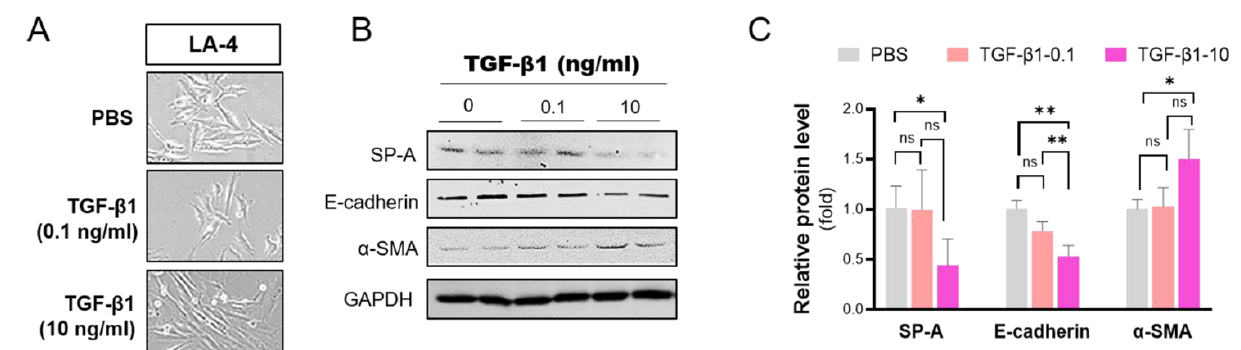
Figure 5. TGF-β1 downregulates SP-A levels in lung alveolar epithelial LA-4 cells. LA-4 cells were induced with various concentrations (0, 0.1, 10 ng/mL) of TGF-β1 for 24 h. ( A ) Morphological changes were observed under light microscopy (shown at 400x magnification). ( B , C ) The protein levels of SP-A, E-cadherin, and α-SMA were evaluated by Western blotting ( B ) and subsequently analyzed by densitometry using ImageJ ( C ). The relative level of these proteins was normalized to GAPDH and calculated as fold change compared to those in PBS-treated WT group. The data are presented as the mean ± SE. * p < 0.05, ** p < 0.01. ns indicates no significant difference between groups. n = 3 per group.